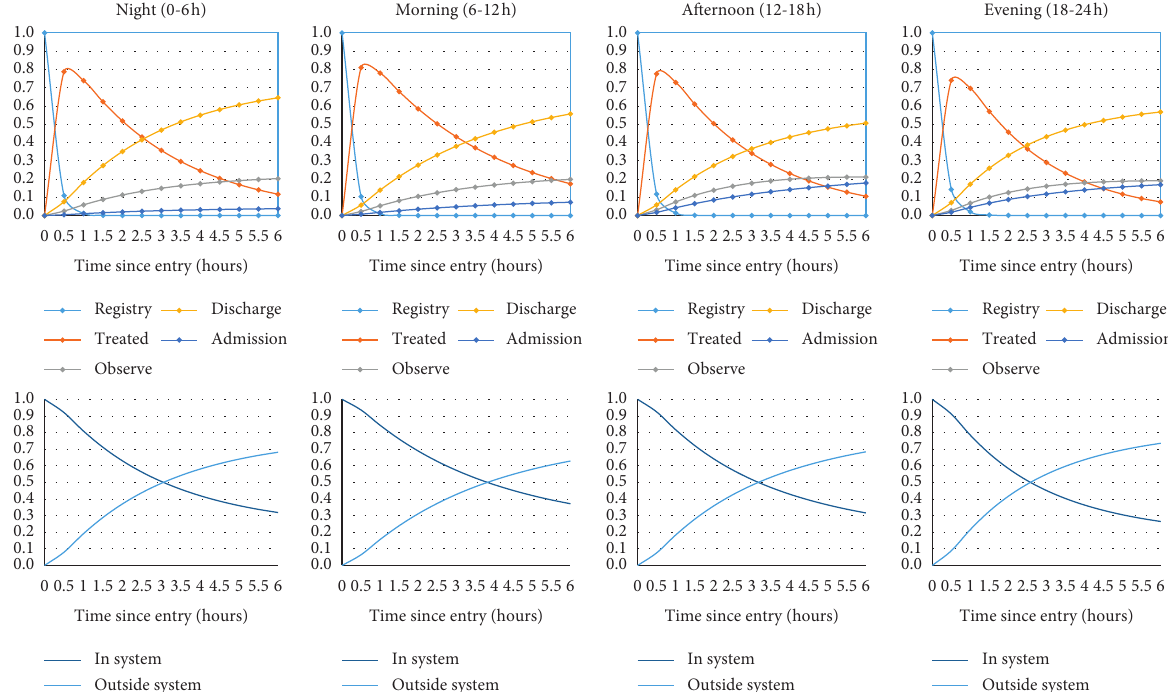
Figure 3: Predictive dynamic distribution of a patient who arrives at 0000, 0600, 1200, and 1800, using the estimated parameters of six-hour time periods. Upper, possibility of being in different states within the next six hours. Lower, probability of being inside or outside the ED